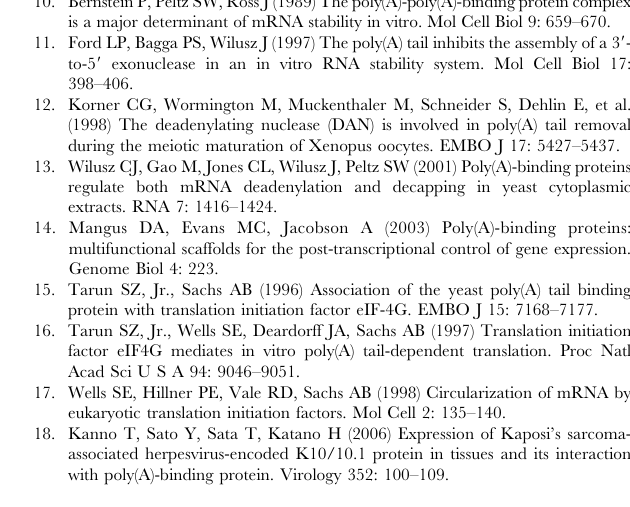
Figure S8 Manual scoring of RTA and K8.1 expression in BCBL1 TReX-RTA cells electroporated with no oligonucleotide (mock), anti-GFP, anti-K7 or anti-PAN oligonucleotides. A. Representative images from those used to score RTA and K8.1 expression in latently infected (top) and lytically infected (bottom) cells. First, DAPI was used to identify healthy cells correctly positioned on the z-axis (panels marked DAPI). Then, RTA-myc expression was scored by overlaying the Alexa Fluor 594 signal (panels marked DAPI + RTA). Finally, K8.1 expression was scored by overlaying the Alexa Fluor 488 signal (panels marked DAPI + RTA + K8.1). B. Quantification of 4 independent experi- ments (except for the anti-K7 oligonucleotide transfection, where n =3). 10 randomly chosen fields, each containing about 60–70 cells, were scored per treatment for each experiment. Standard error of the mean is shown, and Student’s t-test values are as follows: anti-GFP versus anti-K7 = 0.987, anti-GFP versus anti- PAN= 0.023, anti-K7 versus anti-PAN = 0.045. For one of these 4 experiments, a second person independently scored K8.1 and RTA expression, confirming a significant decline in K8.1 expression comparing anti-K7 and anti-PAN treated cells (Student’s t-test = 0.009). The difference between K8.1 expression in anti-GFP versus anti-PAN treated cells was less significant, as individually scored by this person (Student’s t-test